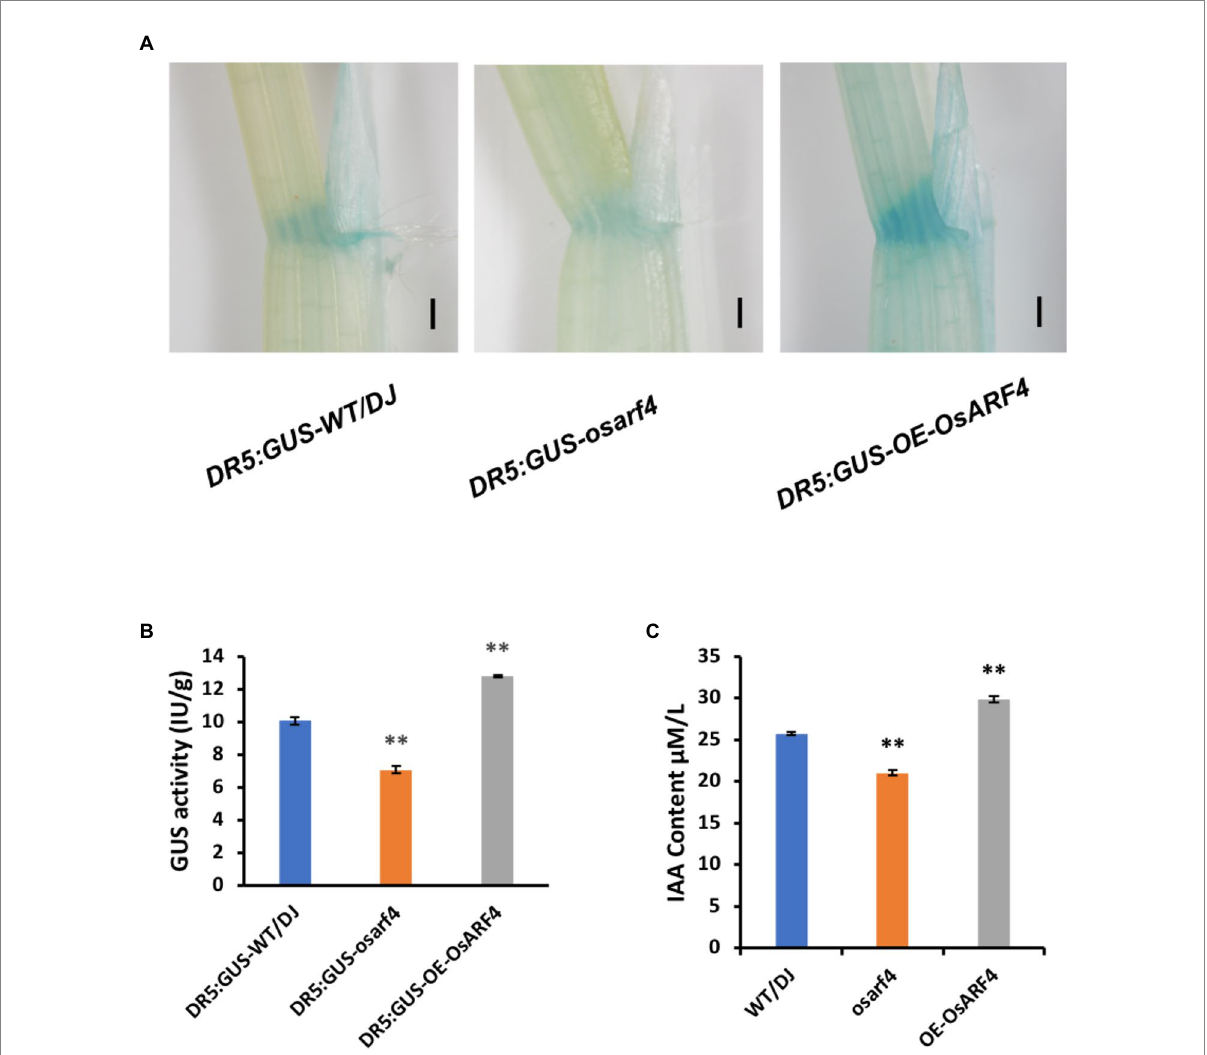
FIGURE 4 Analysis of auxin distribution and content in LJs in WT/DJ, osarf4 mutants, and OsARF4- overexpressing lines. (A) GUS staining of DR5:GUS-WT/DJ , DR5:GUS-osarf4 , and DR5:GUS-OE-OsARF4 transgenic lines in the LJs. Bars = 500 μ m. (B) Quantification of GUS activity in DR5:GUS-WT/DJ , DR5:GUS-osarf4 , and DR5:GUS-OE-OsARF4 transgenic lines. Ten biological replicates were evaluated. ** p < 0.01 indicates a significant difference in means ± SD compared with DR5:GUS-WT/DJ based on Student’s t-test . (C) Determination of auxin contents in LJs of WT/DJ, osarf4 mutants, and OsARF4- overexpressing lines. Five separate biological replicates were used in each test. ** p < 0.01 indicates significant differences from WT/DJ based on Student’s t-test